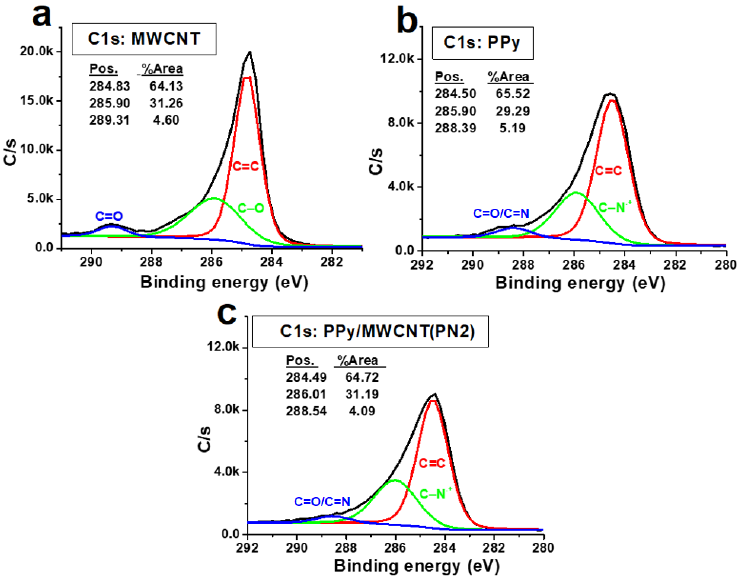
Figure 8. C1s XPS profiles of ( a ) MWCNTs, ( b ) PPy, and ( c ) MWCNTs/ PPy nanocomposites (PN2).